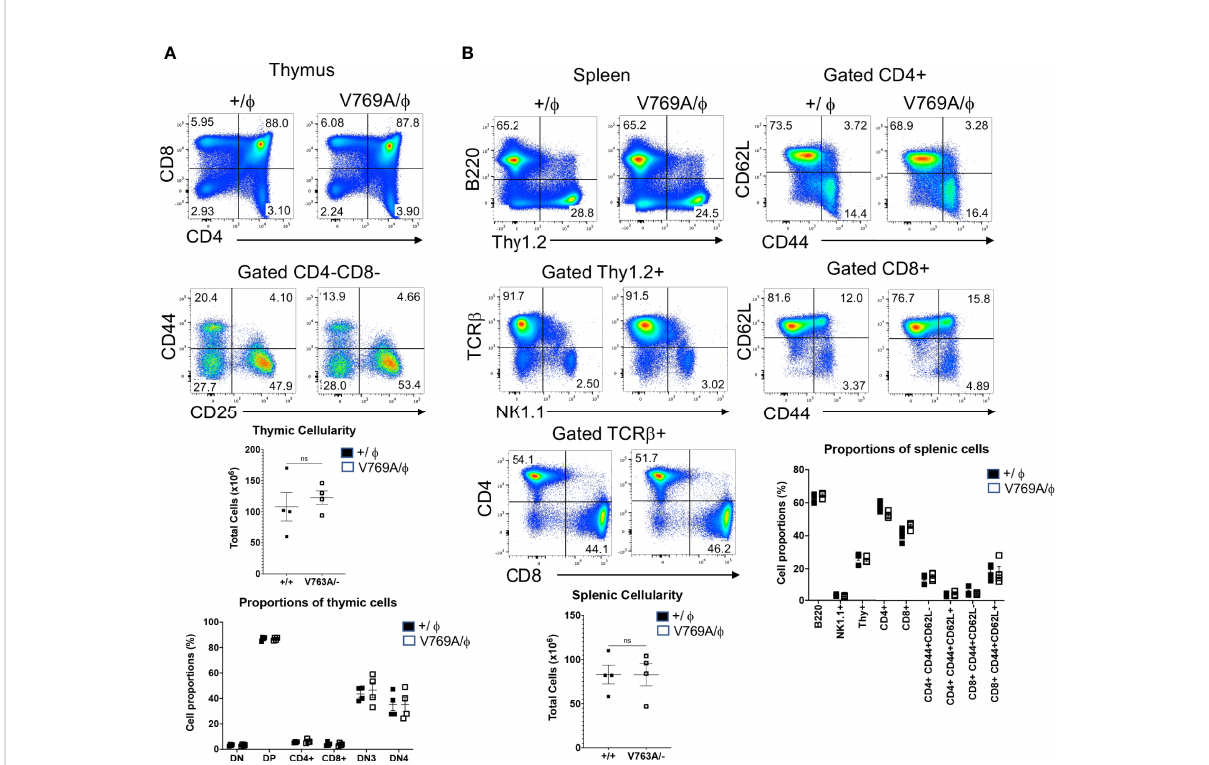
FIGURE 4 Phenotypic analysis of lymphoid development in Med14 mutant mice. (A) Histograms are displayed of fl ow cytometry analysis of thymic cell suspensions from wildtype (+/ f ) and hemizygous Med14 mutant (V769A/ f ) mice. The following antibodies were used: CD4, CD8, CD44, and CD25. Scatter plots of total thymic cellularity and the frequencies of the indicated populations are depicted. The following populations are graphed: DN, CD4-CD8-; DP, CD4+CD8+; CD4+; CD8+; DN3, CD4-CD8-CD44-CD25+; DN4, CD4-CD8-CD44-CD25-. Proportion of DN3 and DN4 subpopulations among DN thymocytes is depicted graphically (B) Histograms are displayed that illustrate fl ow cytometric analysis of the lymphoid content of spleens from +/ f and V769A/ f mice. The following antibodies were used: B220, Thy1.2, NK1.1, CD4, CD8, TCR b , CD44, and CD62L. Scatter plots of total splenic cellularity and the frequencies of the indicated populations are depicted. Each symbol represents an individual mouse. The proportions of CD4 and CD8 T cells among Thy1+ cells and the proportions of memory subsets among CD4+ and CD8+ subsets are depicted graphically. Data are representative of 3 experiments performed. No statistically signi fi cant differences were found in any of the indicated